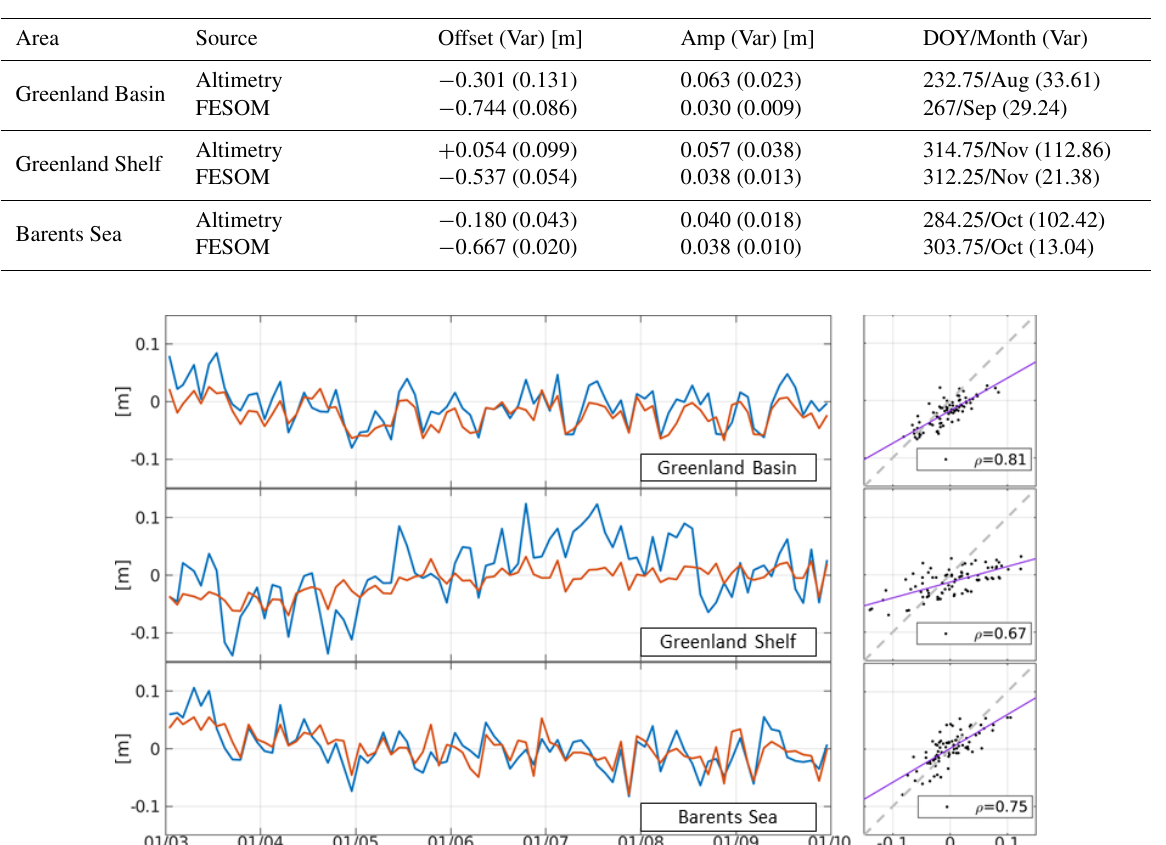
Table 2. Offset, averaged annual amplitude (Amp) and DOY/month of maximum amplitude with variability (Var) in three subregions.